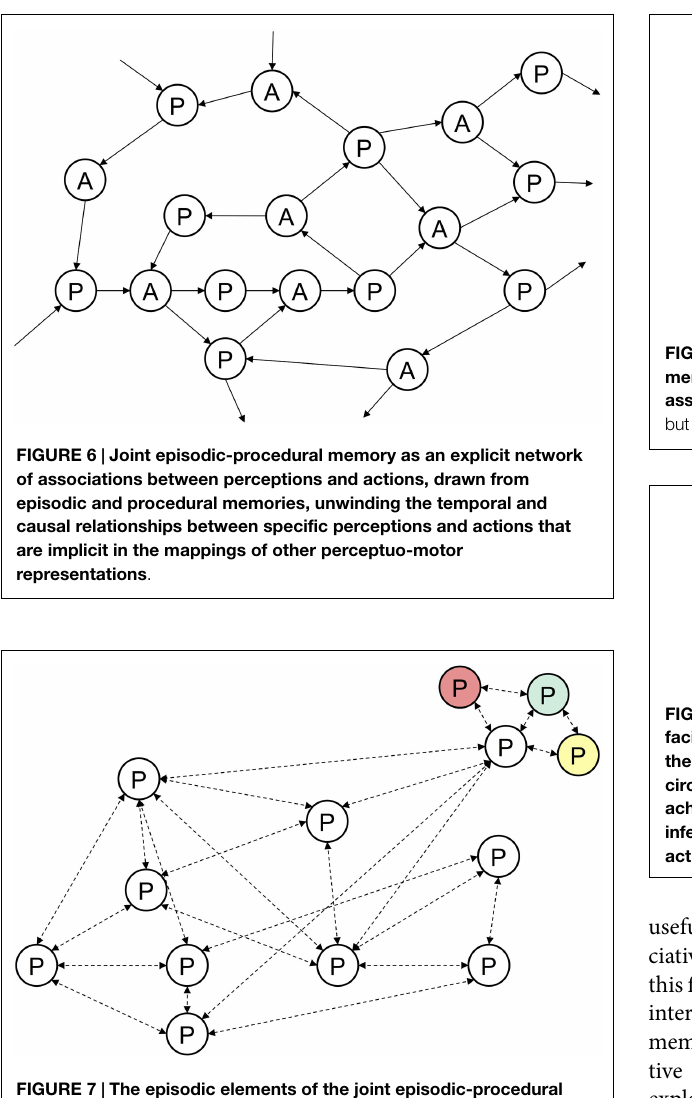
FIGURE 7 | The episodic elements of the joint episodic-procedural memory are drawn from episodic memory and therefore operate associatively in their own right . Furthermore, this provides a way to include other modalities of episodic memory (top right) including affective or hedonic memories.